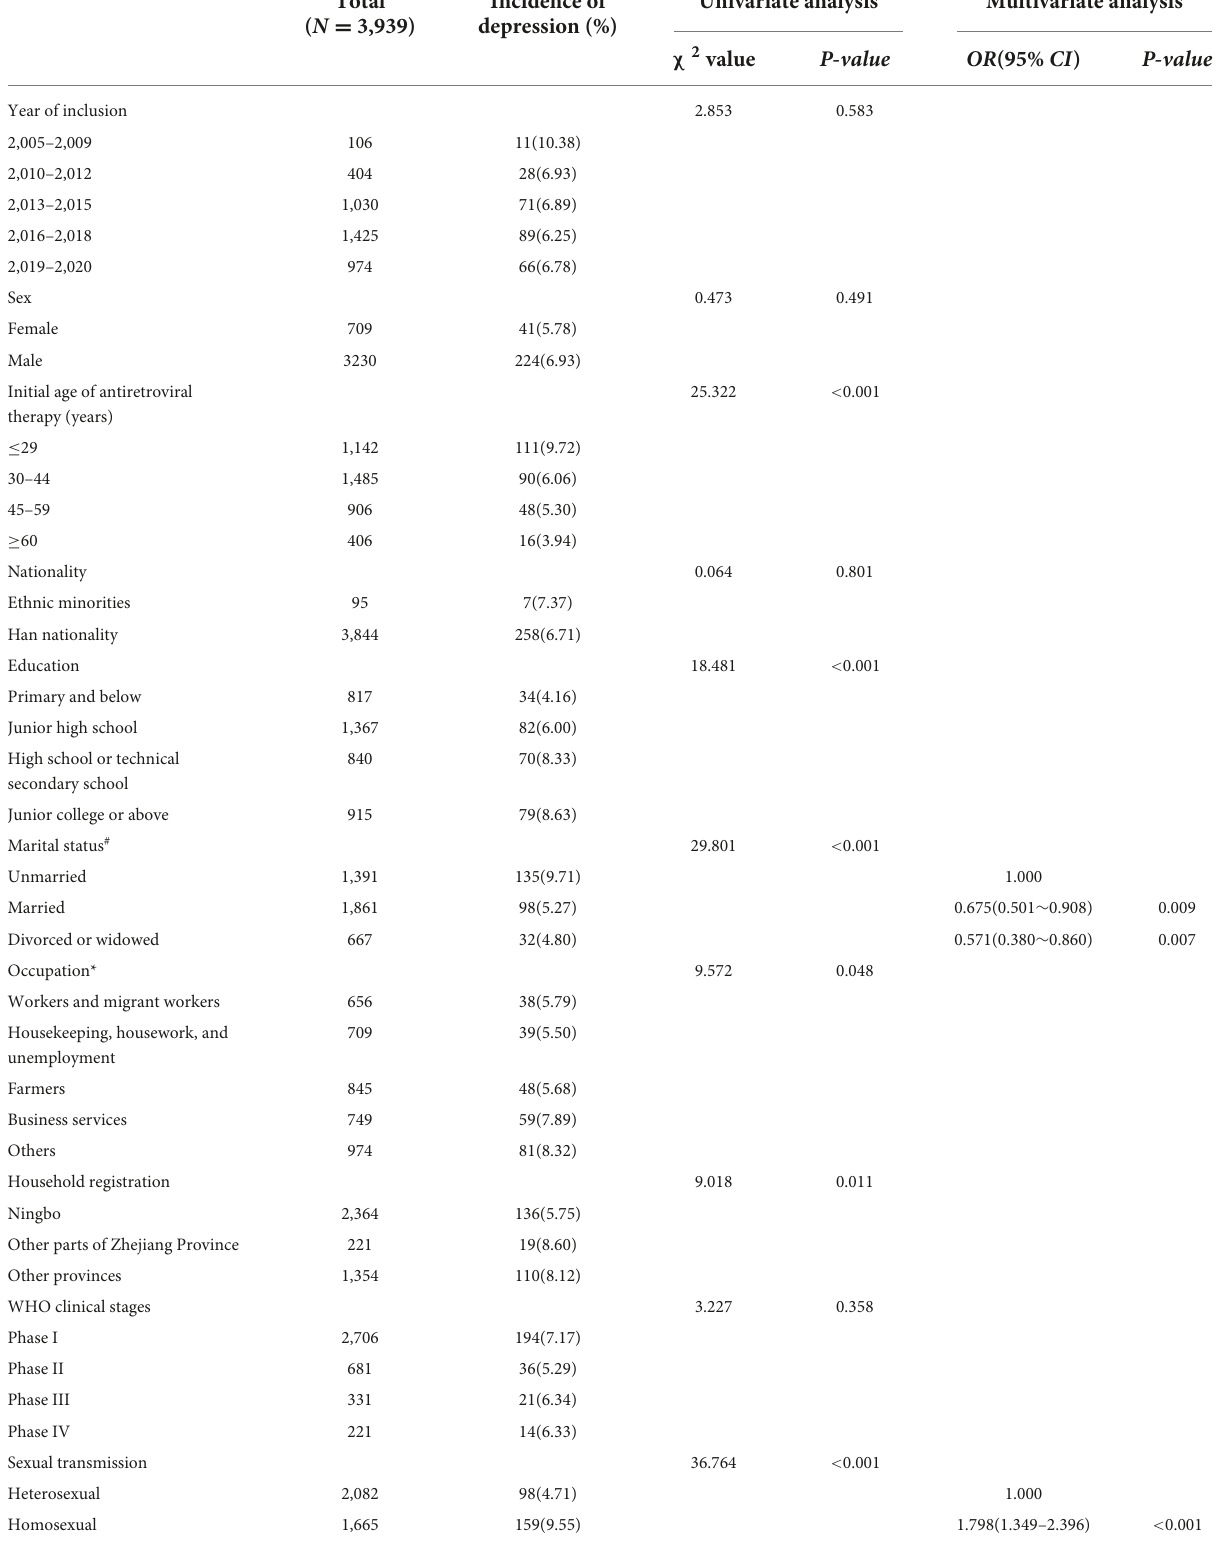
TABLE 2 Analysis on the related factors for depression among HIV/AIDS in